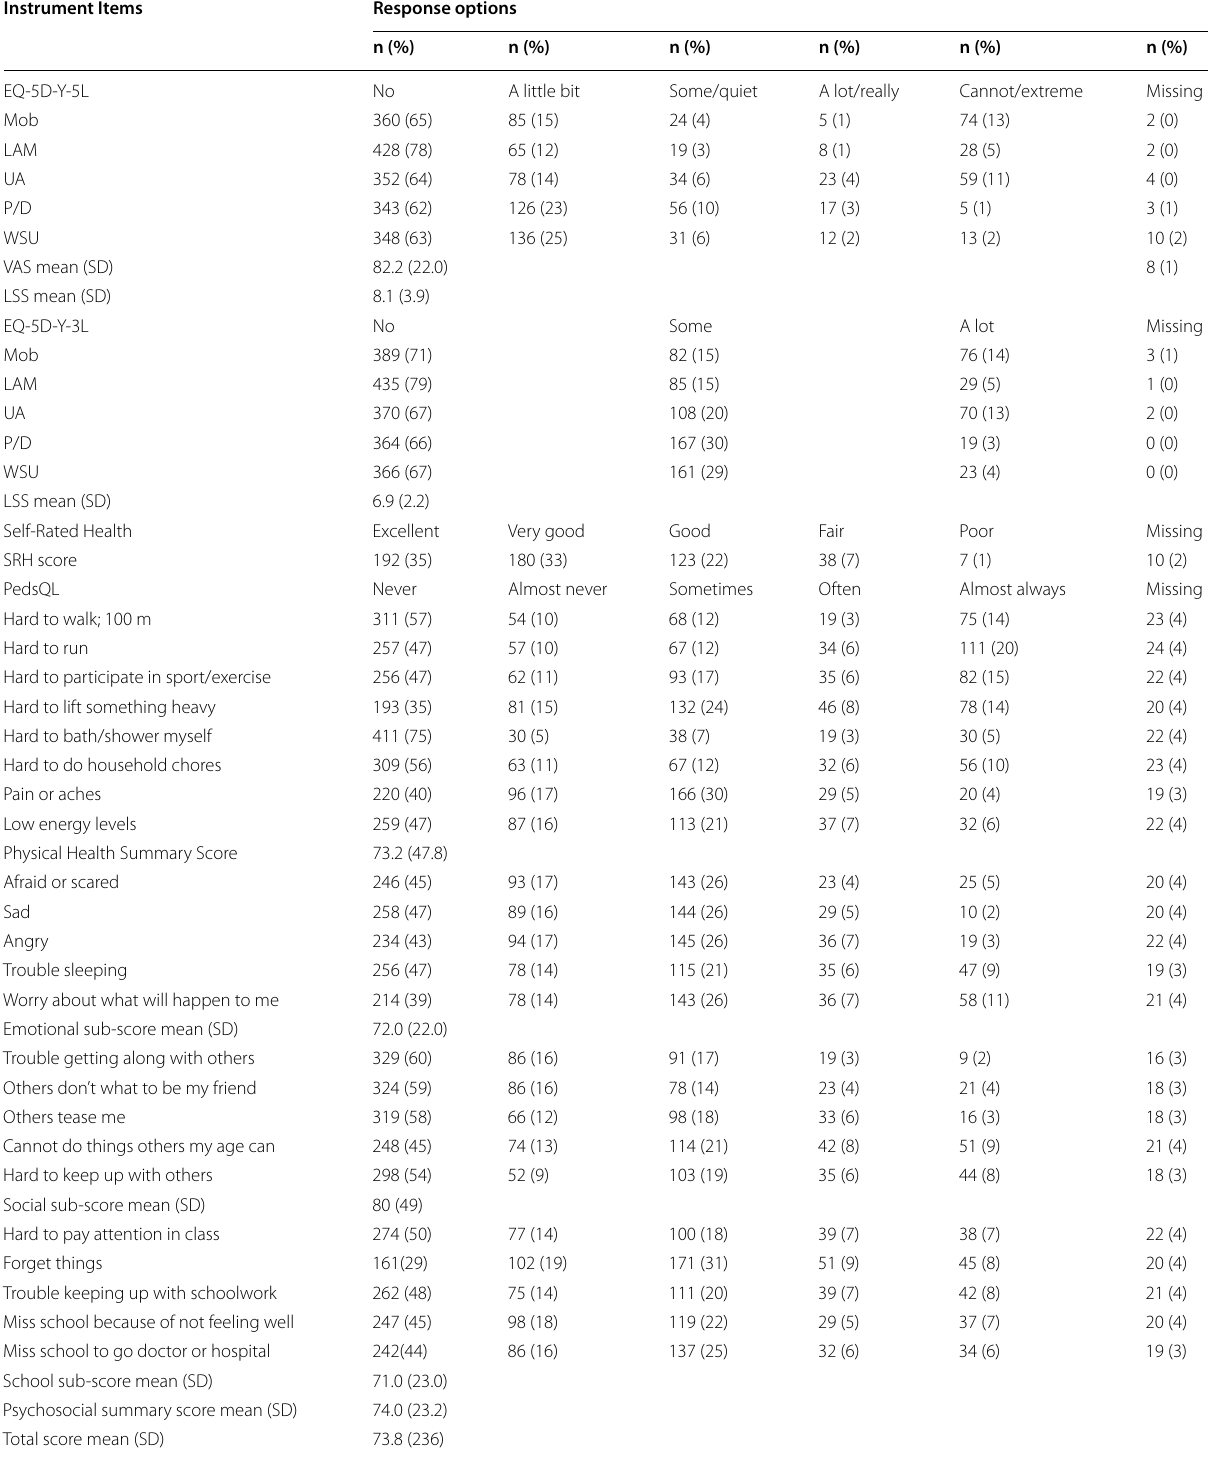
Table 2 Frequency of responses for the EQ-5D-Y-5L, EQ-5D-Y-3L, Self-Rated Health (SRH) score and